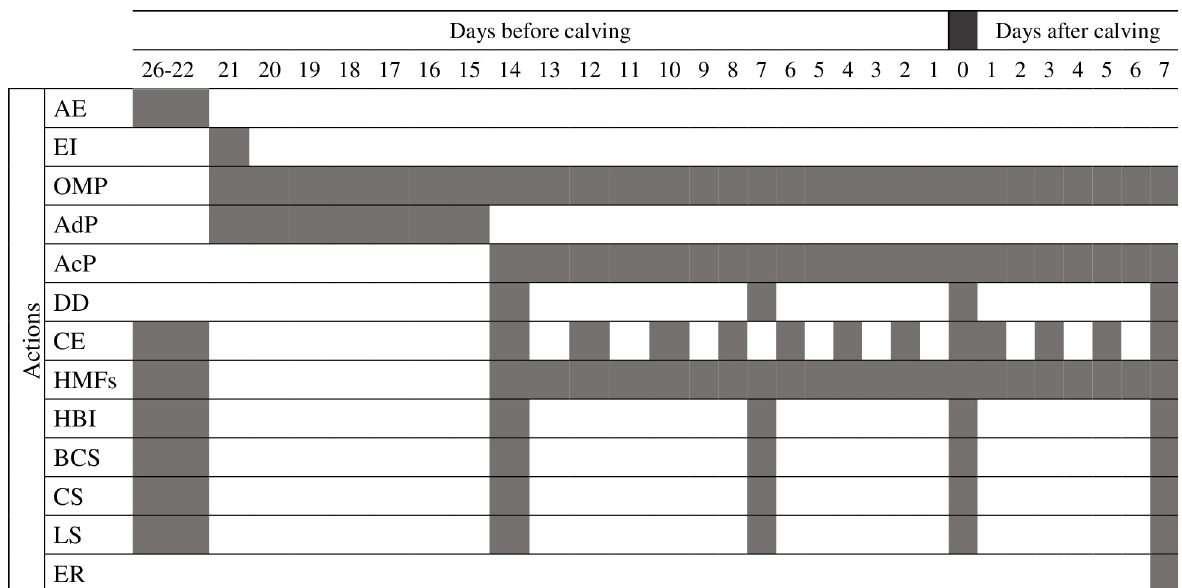
Fig 1. Visual representation and timing of the different actions performed on each cow enrolled. AE = animal enrolment; EI = equipment installation; OMP = overall monitoring phase; AdP = adaptation phase; AcP = acquisition phase; DD = data download; CE = clinical examination; HMFs = health monitoring by farm-staff three time/d HBI = hemato-biochemical investigation; BCS = body condition scoring; CS = cleanliness scoring; LS = locomotion scoring; ER = equipment removal.